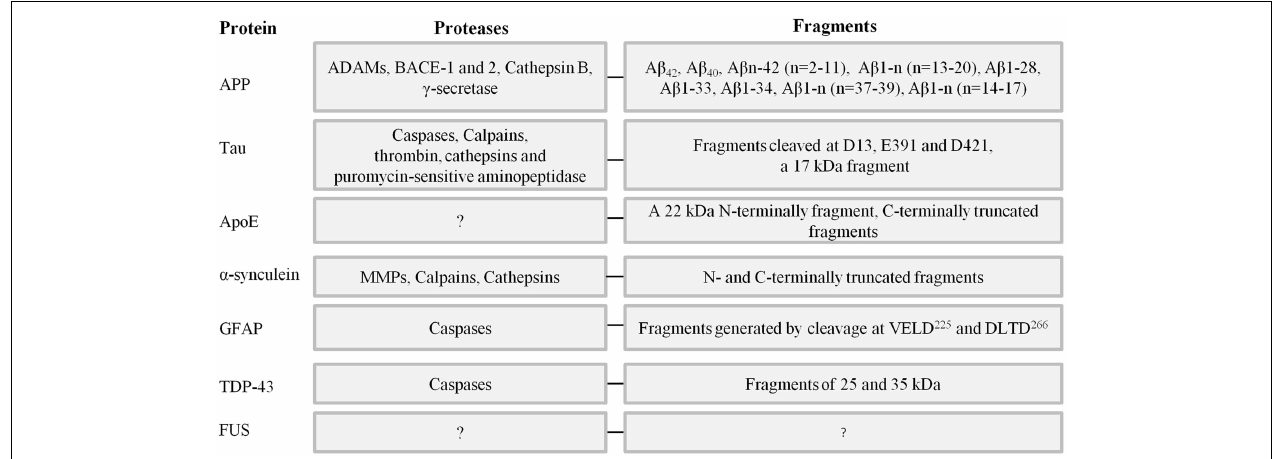
FIGURE 2 | Key neuronal proteins involved in the proteopathy of different types of dementia, proteases involved in their truncation and fragments known from the literature . References can be found in the text.